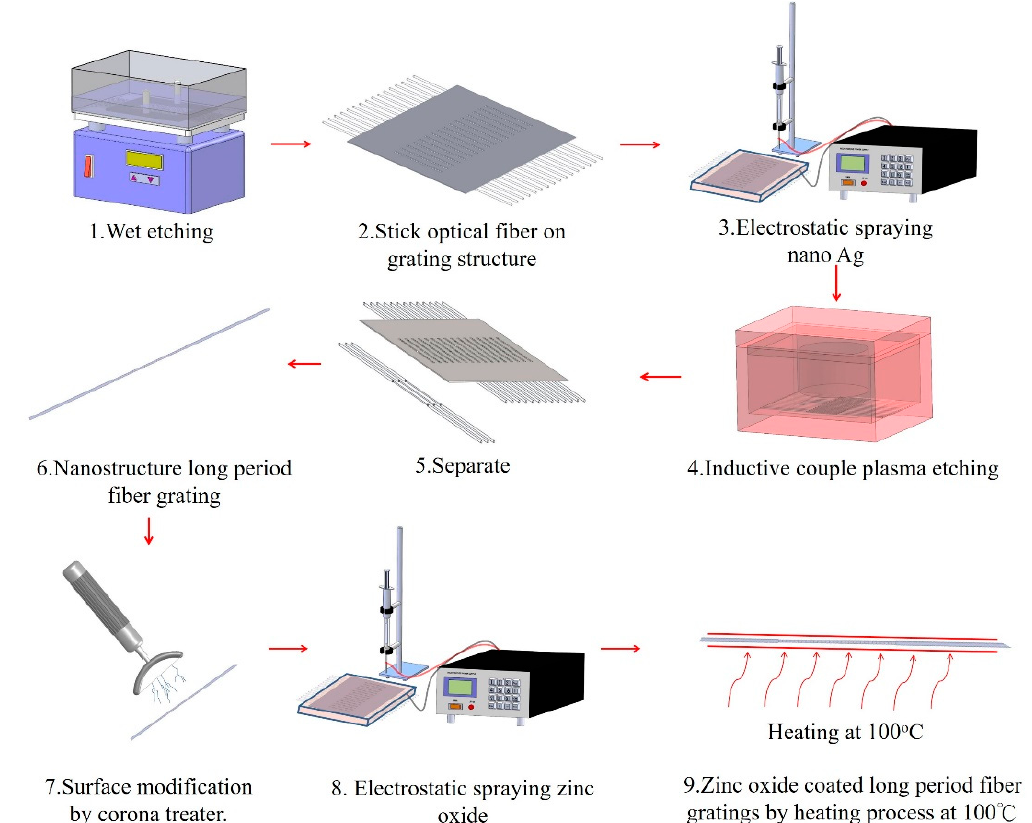
Figure 1. Zinc oxide (ZnO) nanoparticle-coated long period fiber grating (LPFG) carbon dioxide (CO 2 ) gas sensor manufacturing process.